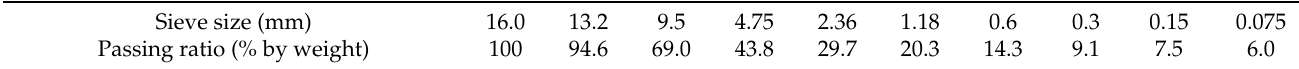
Table 4. Aggregate gradation for control asphalt